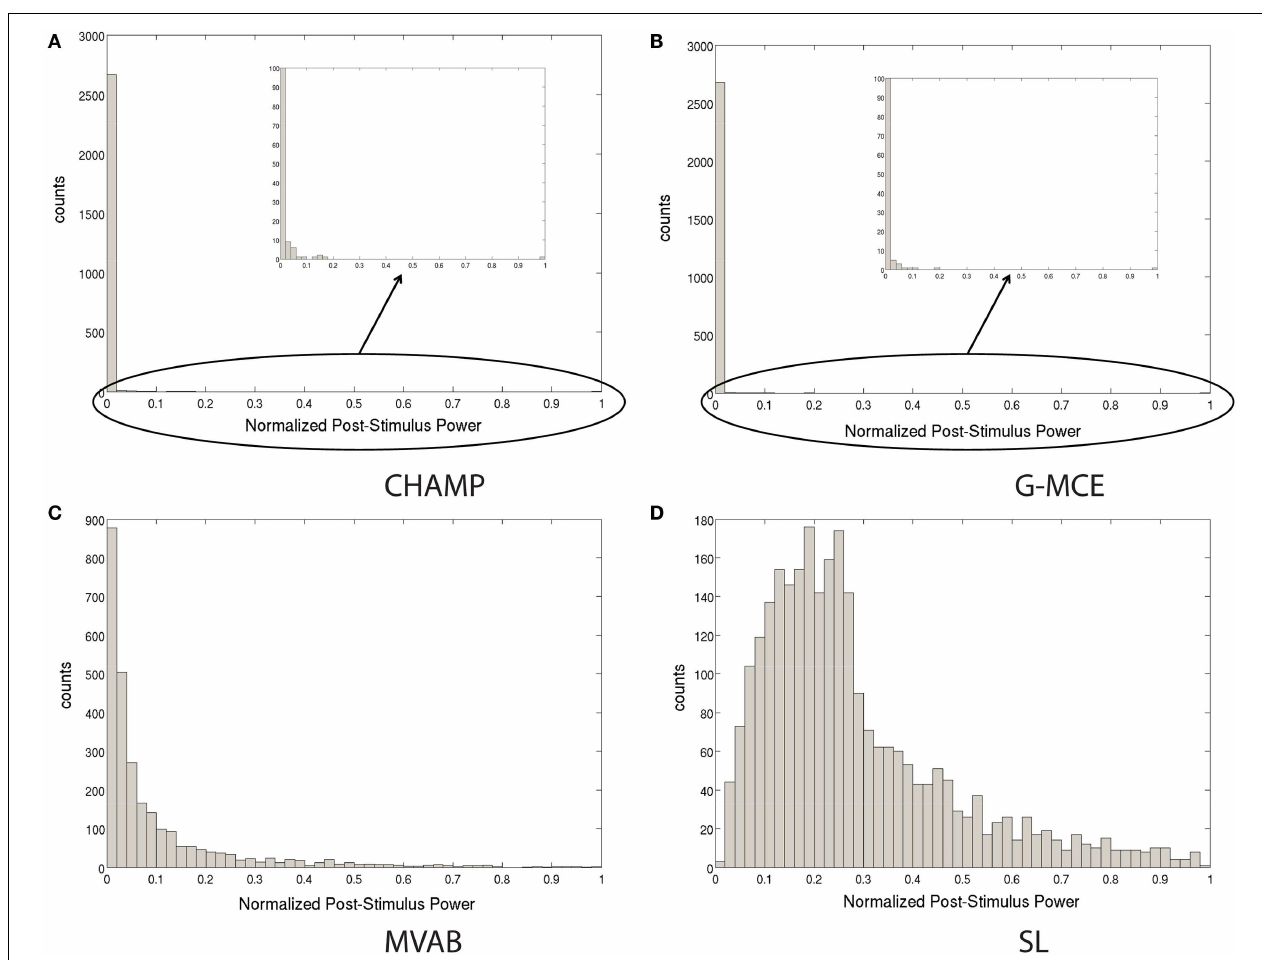
FIGURE 2 | Histograms of the post-stimulus power to illustrate the difference between sparse algorithms, Champagne (A) and G-MCE (B), and non-sparse algorithms, MVAB (C) and SL